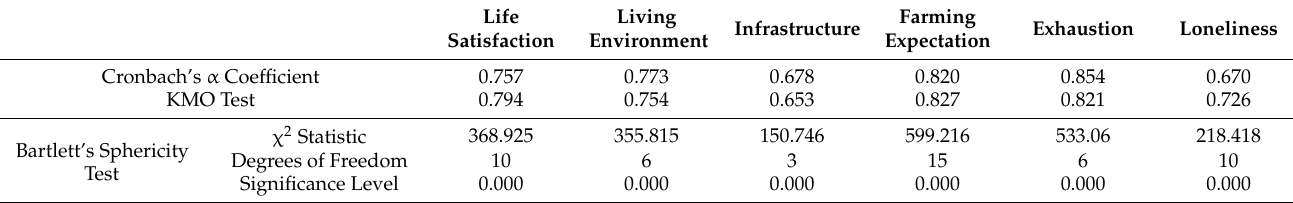
Table 3. Cronbach’s α Coefficient, KMO Test and Bartlett’s Sphericity